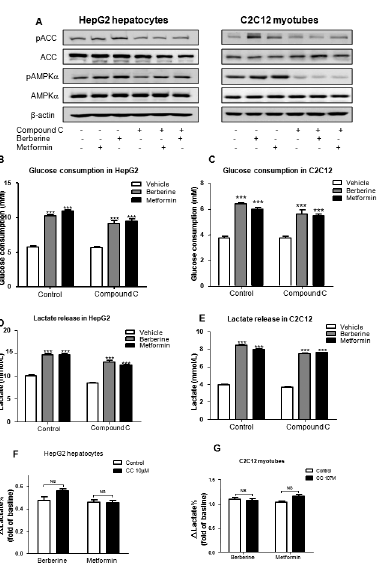
Figure 6. Effects of berberine on AMPK pathway, glucose consumption and lactate release in the presence of compound C. Cells were preincubated with compound C (10 m mol/L) for 30 min, then treated with 20 m mol/L berberine or 10 mmol/L metformin in serum-free DMEM with 0.25% BSA and 15 mM D-glucose for 24 h. Whole cell lysate protein was used to measure the phosphorylation of AMPK (pAMPK) and ACC (pACC) by Western blot in HepG2 hepatocytes and C2C12 myotubes (A). Effects of berberine and metformin on glucose consumption were checked in HepG2 (B) and C2C12 (C) cells; effects of berberine and metformin on lactate release were checked in HepG2 (D) and C2C12 (E) cells. Increasing rates of lactate release stimulated by berberine and metformin in the presence or absence of compound C in HepG2 (F) and C2C12 (G) cells were calculated. Results are shown as means 6 SEM from at least three independent experiments; *** P , 0.001 vs . control in corresponding group.